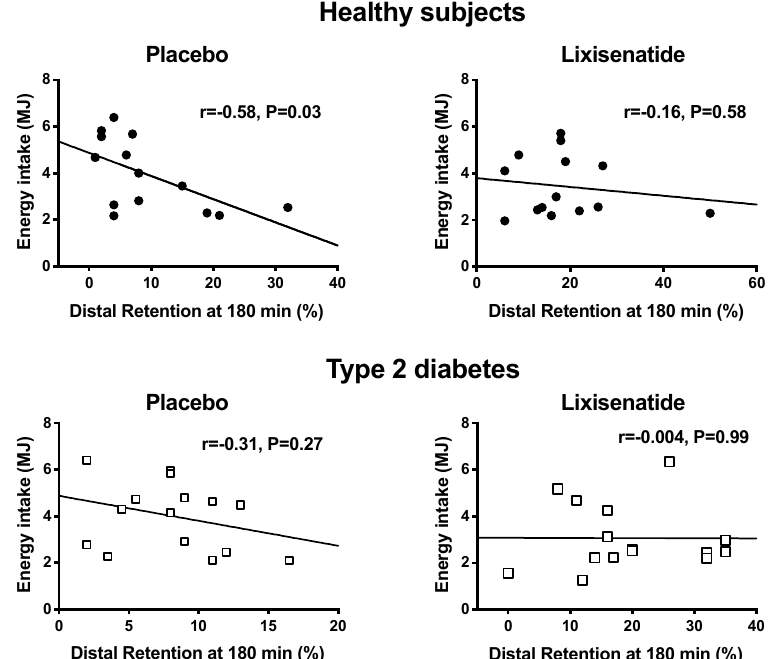
Figure 3. Relationships between energy intake (MJ) consumed at the bu ff et-style meal and retention in the distal stomach at 180 min after a drink containing 75 g glucose in healthy participants (black circles) following placebo ( r = − 0.58, p = 0.03) and lixisenatide ( r = − 0.16, p = 0.58) and patients with T2D (open squares) following placebo ( r = − 0.31, p = 0.27) and lixisenatide ( r = 0.004, p = 0.99).